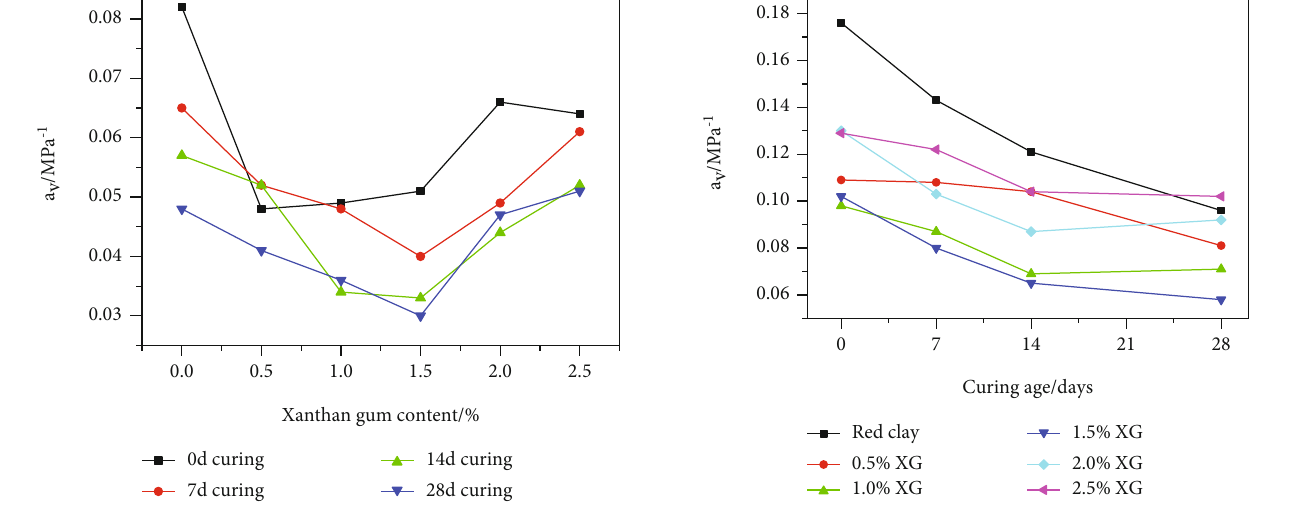
Figure 6: Relationship of xanthan gum content and compression coe ffi cient.